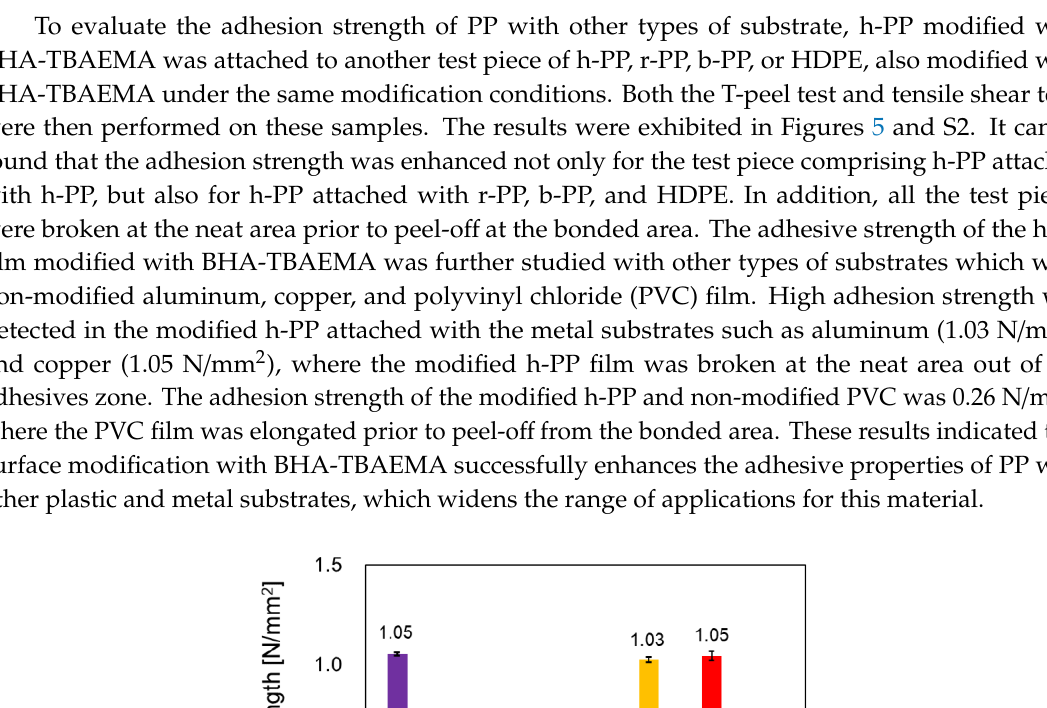
Figure 4. Photos of the test pieces after evaluation by adhesion measurement: ( a ) T-peel test; ( b ) tensile shear test.